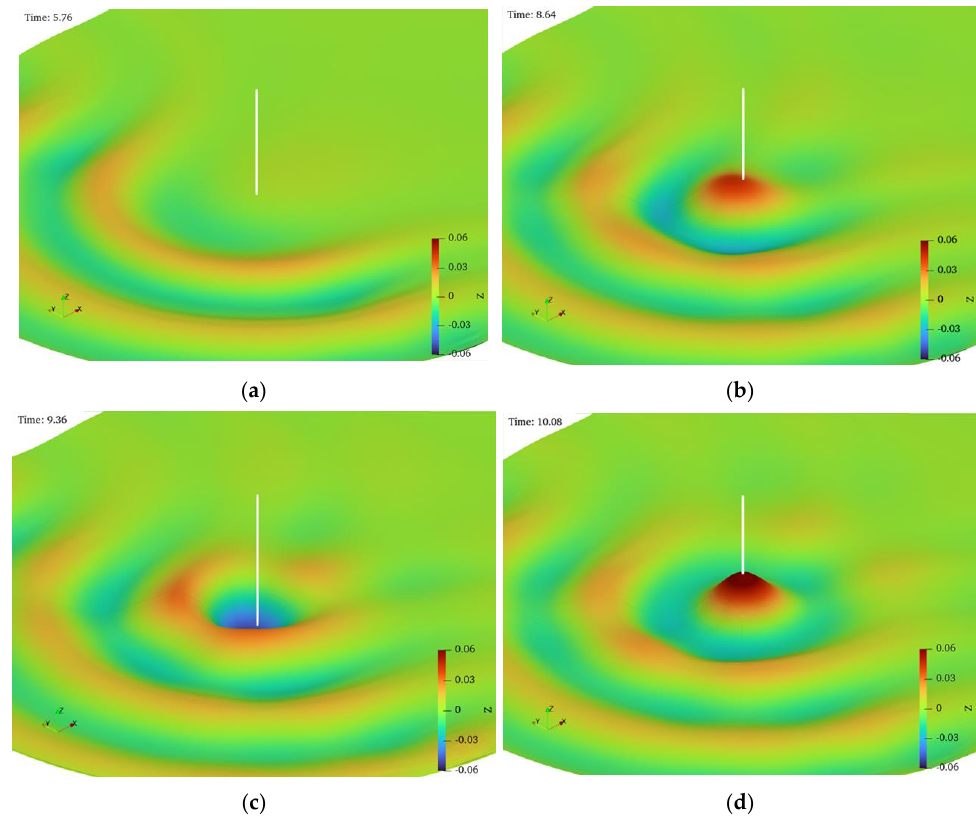
Figure 11. Z-elevation contours of rogue waves (the vertical white column refers to x = 0, and y = 0):